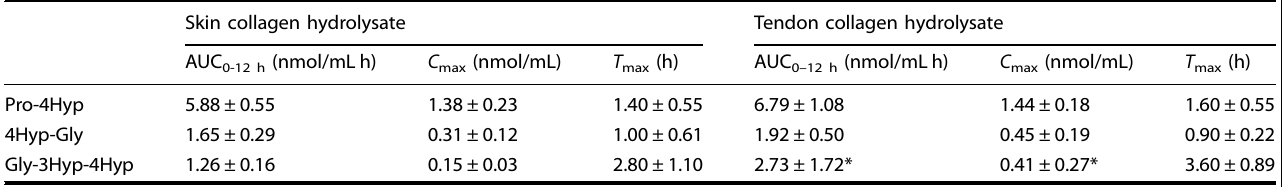
Table 2. AUC 0 – 12 h , C max , and T max of Pro-4Hyp, 4Hyp-Gly, and Gly-3Hyp-4Hyp in mouse plasma after oral administration of collagen hydrolysate prepared from bovine skin or tendon. Skin collagen hydrolysate Tendon collagen